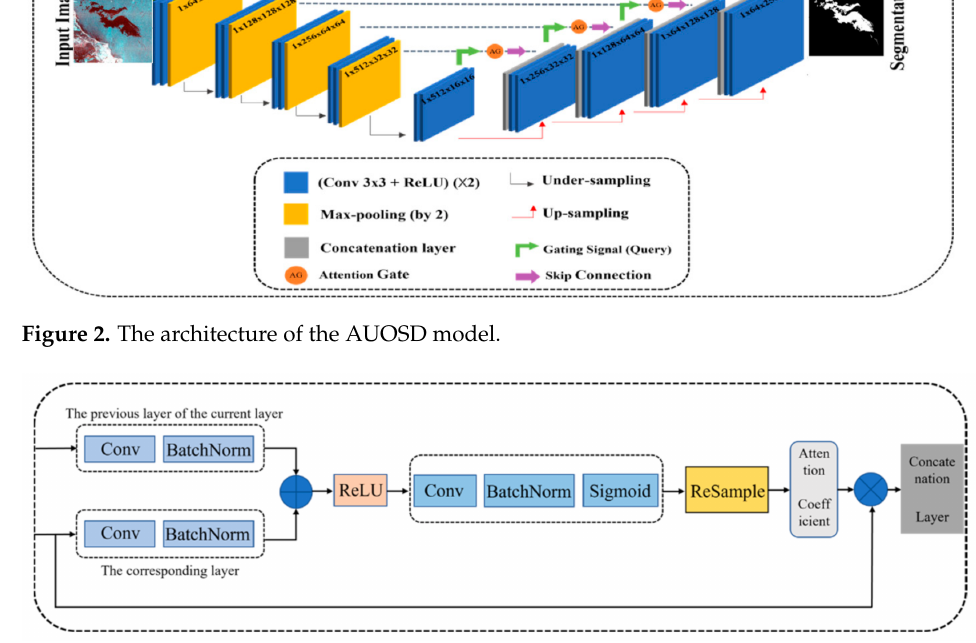
Figure 3. The internal AG modules in the AUOSD model.